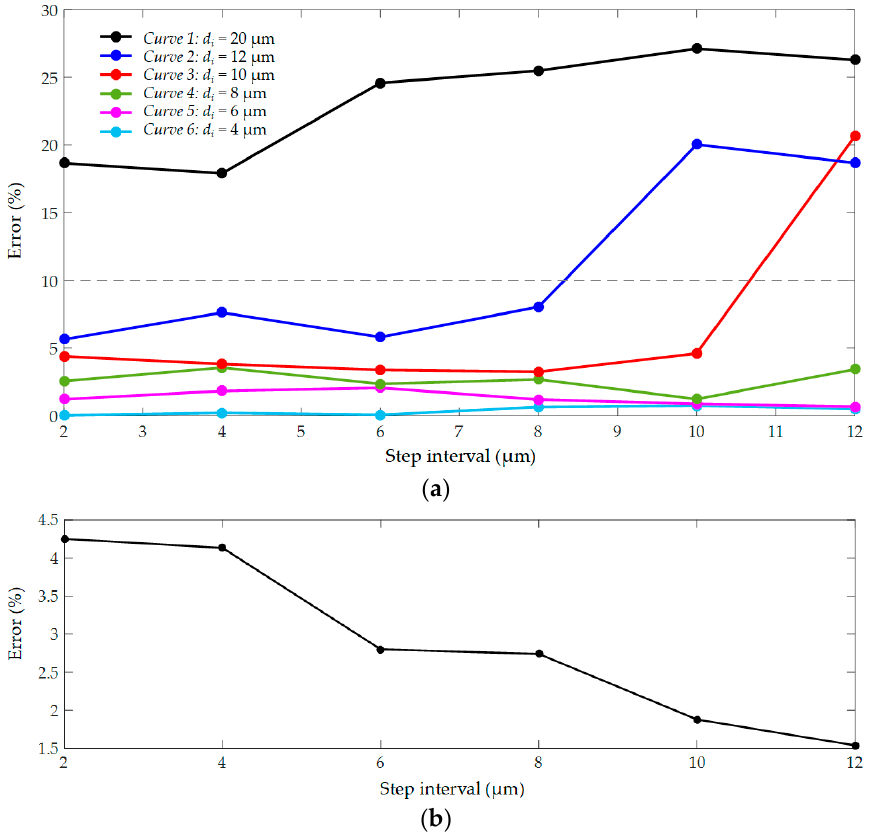
Figure 13. Error of multiple depth from defocus (MDFD): ( a ) Error at different initial depths; ( b ) Error at different step intervals.